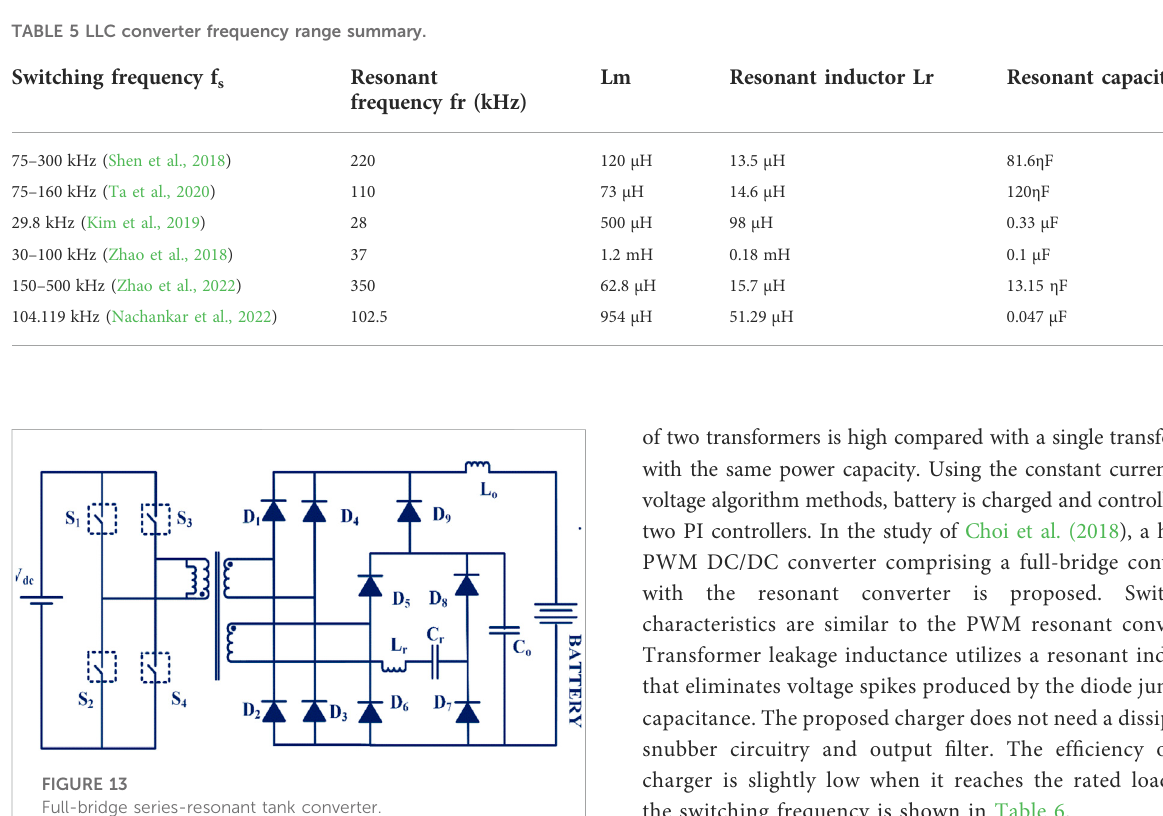
FIGURE 13 Full-bridge series-resonant tank